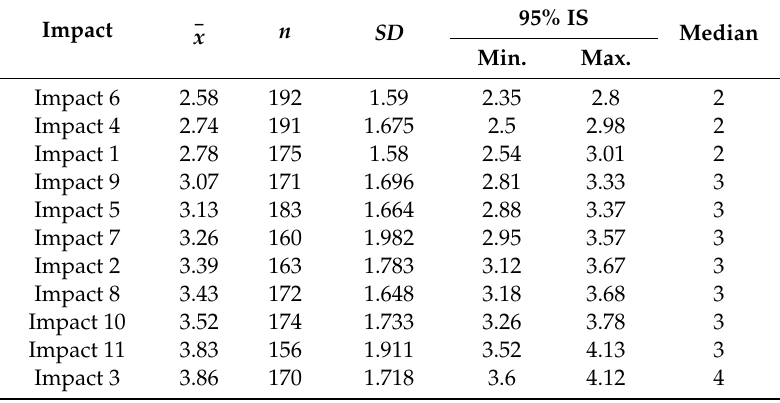
Table 2. The e ff ects of innovative marketing on